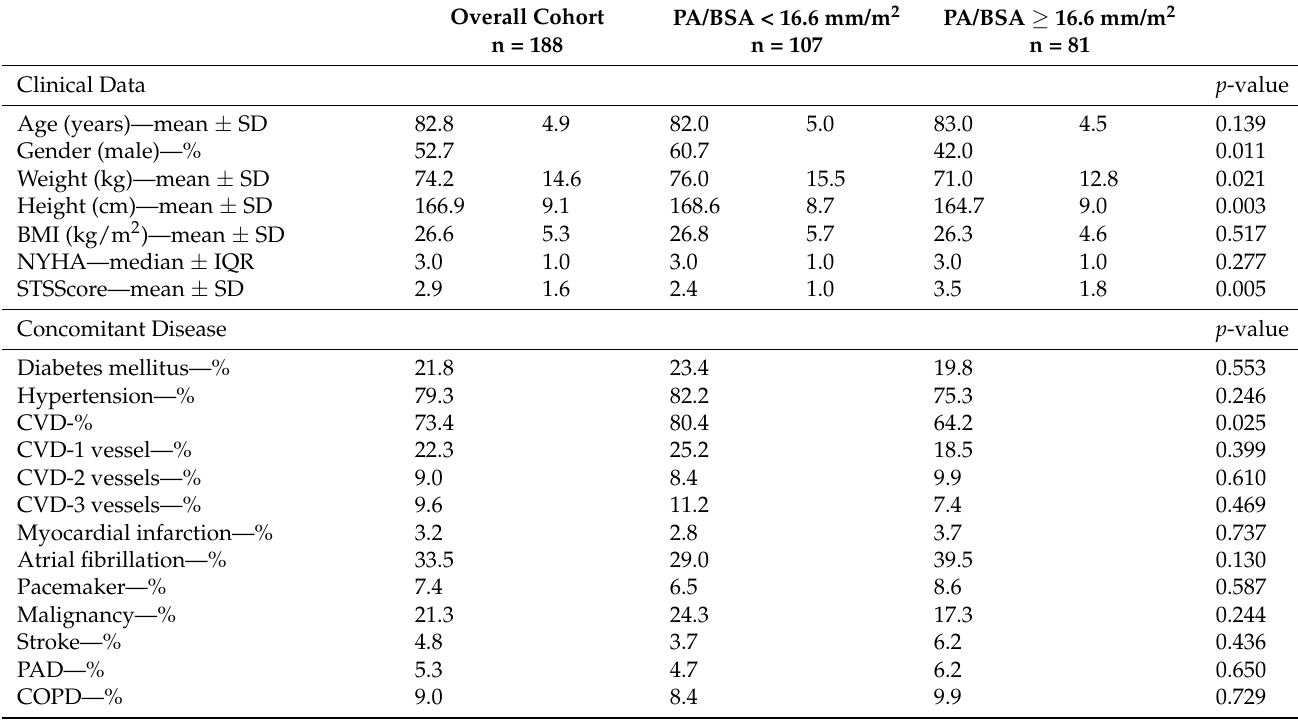
Table 2. Characteristics of the study